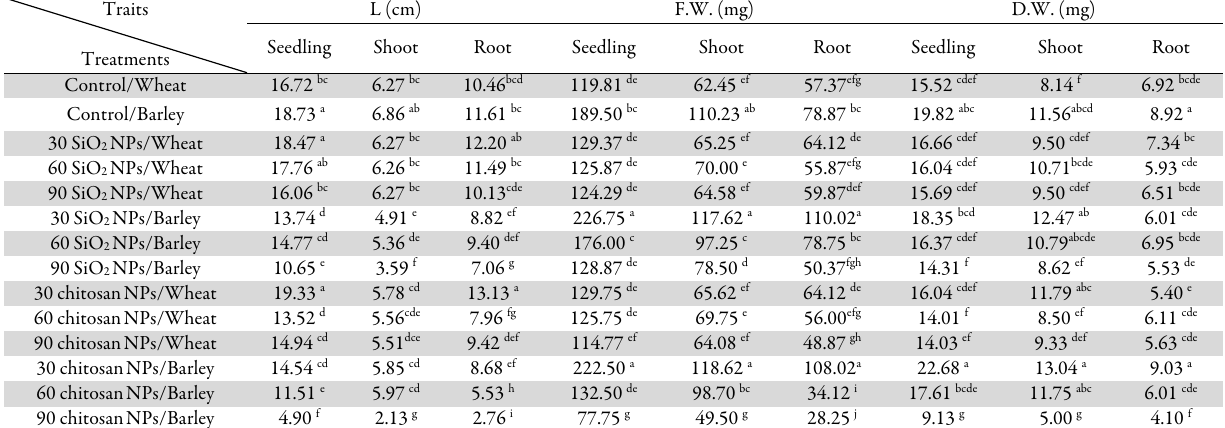
Table 7. Means comparison the effect of SiO 2 and chitosan NPs on growth parameters of wheat and barley